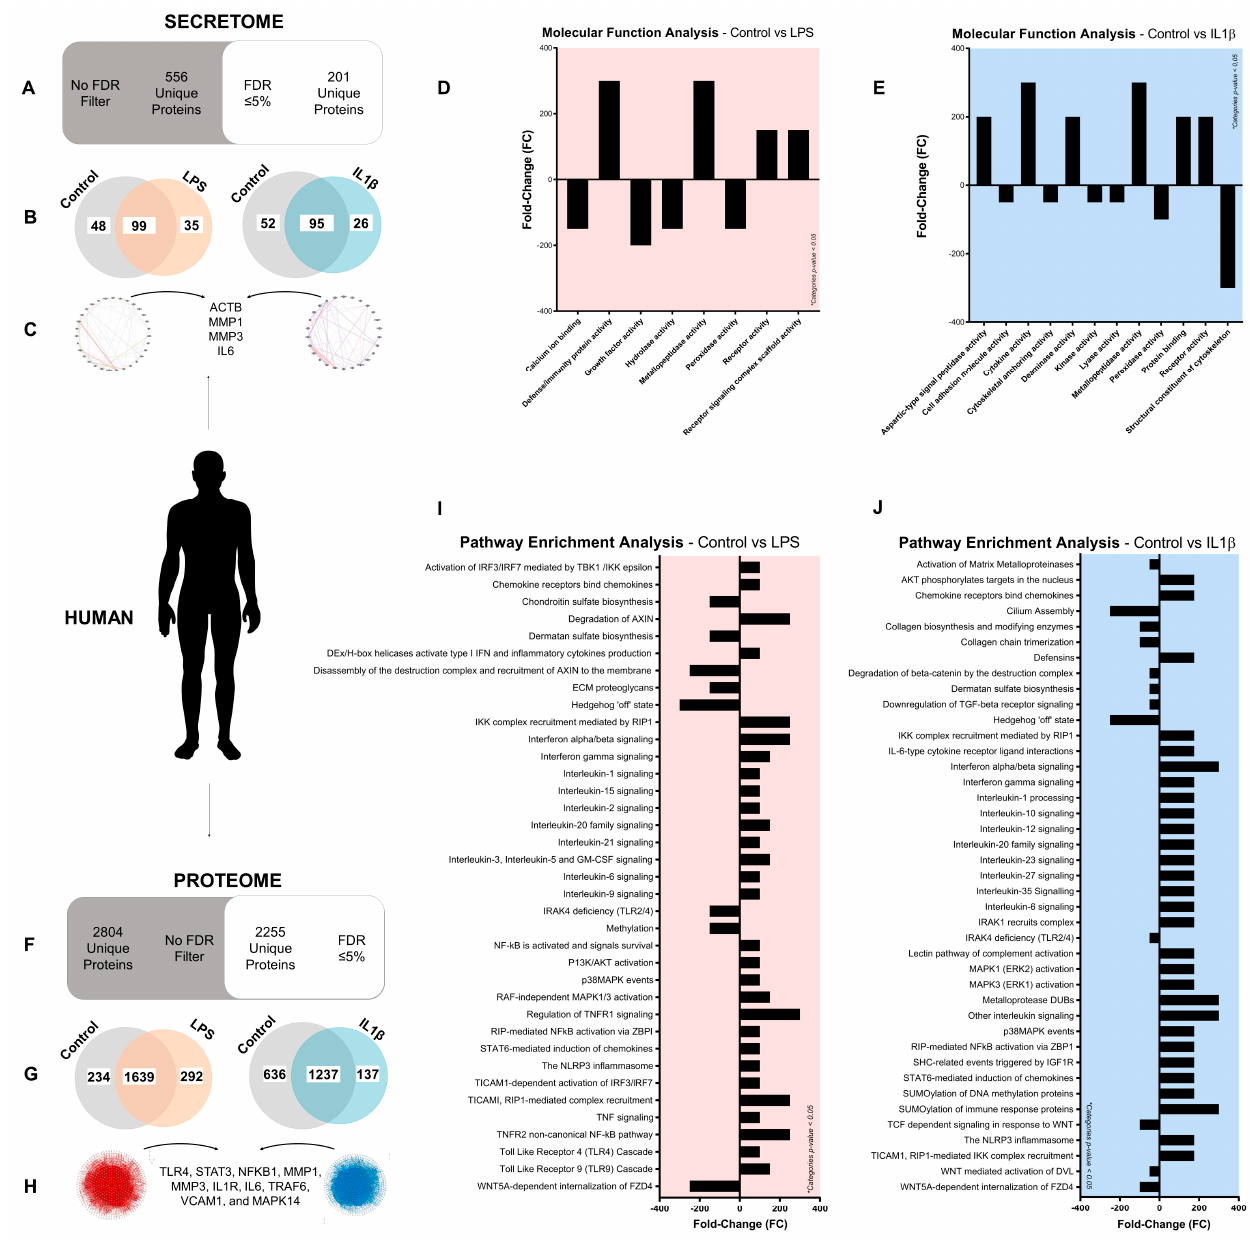
Figure 1. Determining the human secretome and proteome of TLR4/IL1R-activated OA chondro- cytes: ( A–J ) Secretome and proteome profile by DDA MALDI-TOFF of human OA chondrocytes